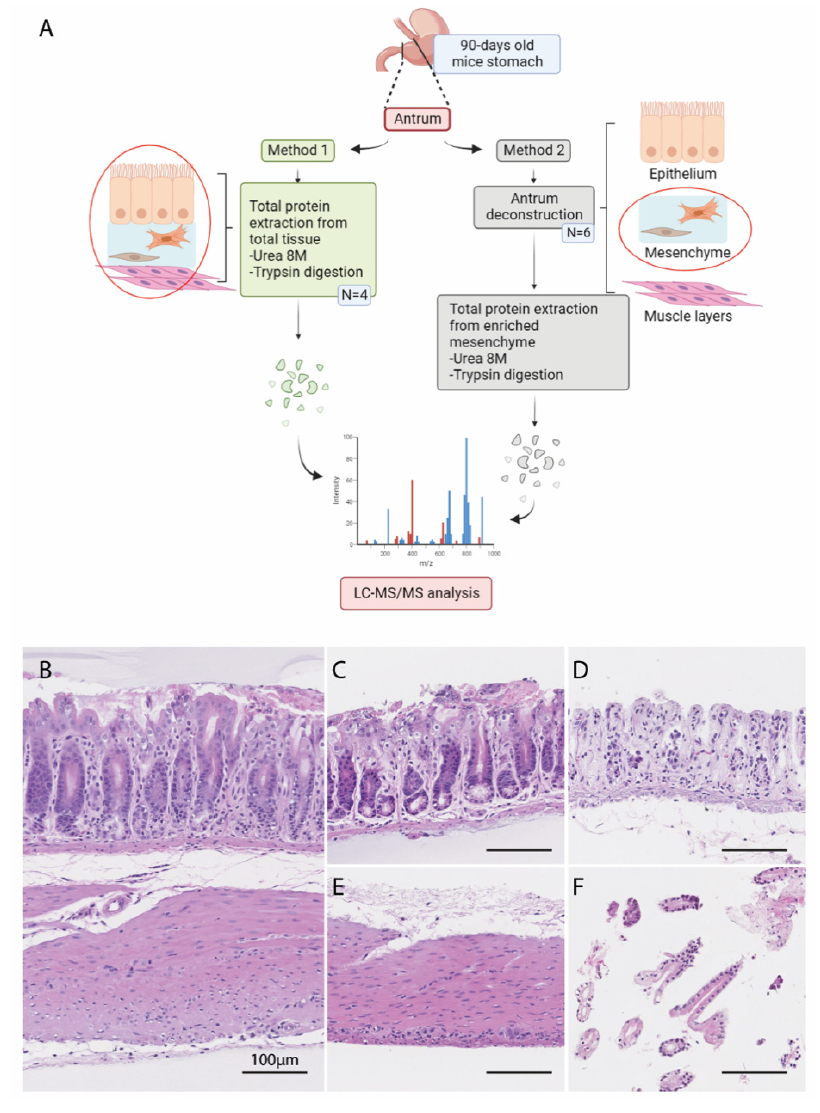
Figure 1. Methods for tissue preparation of stomach antrum for proteomic analysis. ( A ) Schematic representation of the experimental pipeline to assess the gastric matrisome profile in the BmpR1a △ FoxL1+ mouse model. Created with BioRender.com. ( B – F ) Histological assessment of the deconstructed antrum tissue. Total antrum tissue ( B ) was deconstructed in a stepwise manner, where the muscle layers ( E ) were first dissociated from the other two compartments ( C ). Epithelial/mesenchymal tissue ( C ) was further dissociated, yielding the mesenchyme compartment ( D ) and the epithelium ( F ). Scale bar = 100 µm .